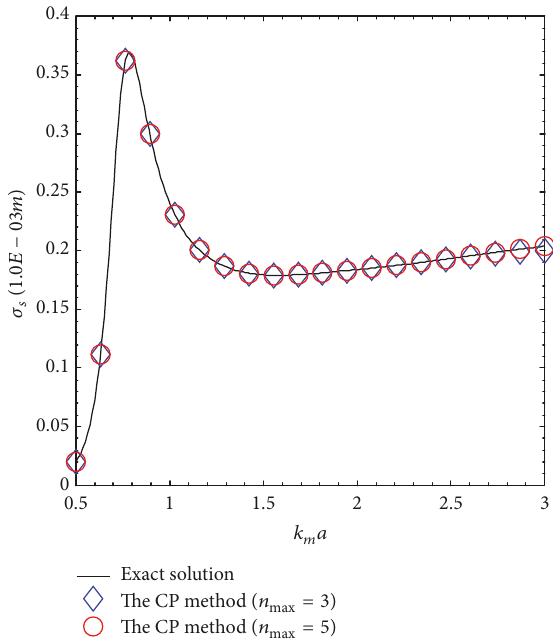
Figure 3: Comparison of 𝜎 𝑠 between the current CP method and exact solutions for the pure imperfect bonding case.